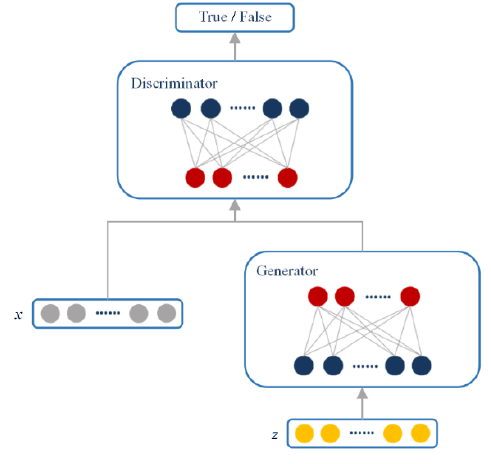
Fig. 1 Structure of GAN.